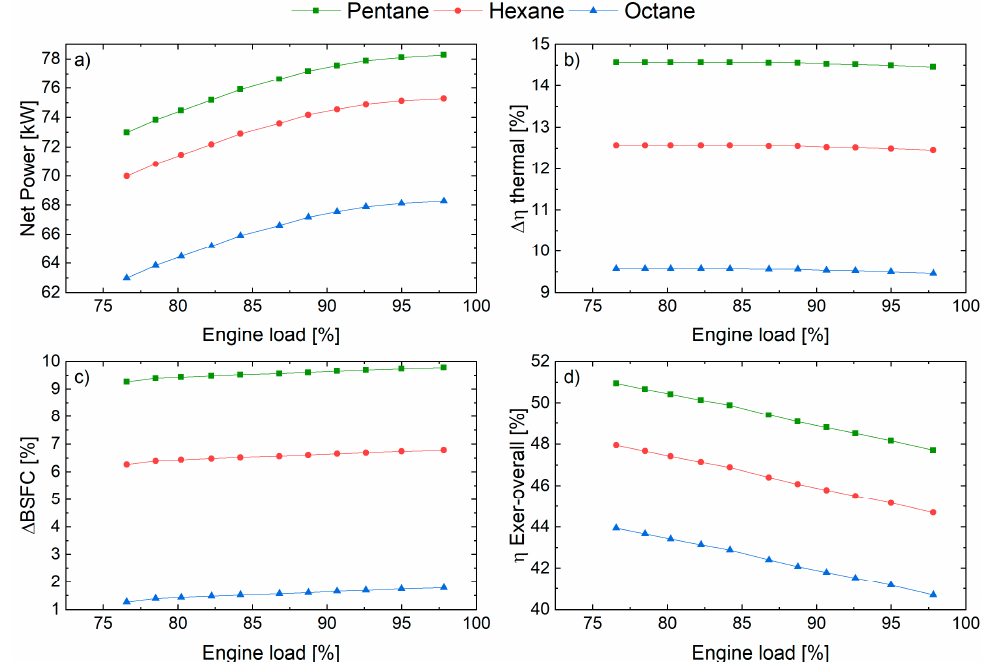
Figure 10. Performance of RORC configurations with di ff erent engine loads. ( a ) Net power; ( b ) Absolute increase in thermal e ffi ciency; ( c ) Specific engine fuel consumption-ORC; ( d ) Overall exergetic e ffi